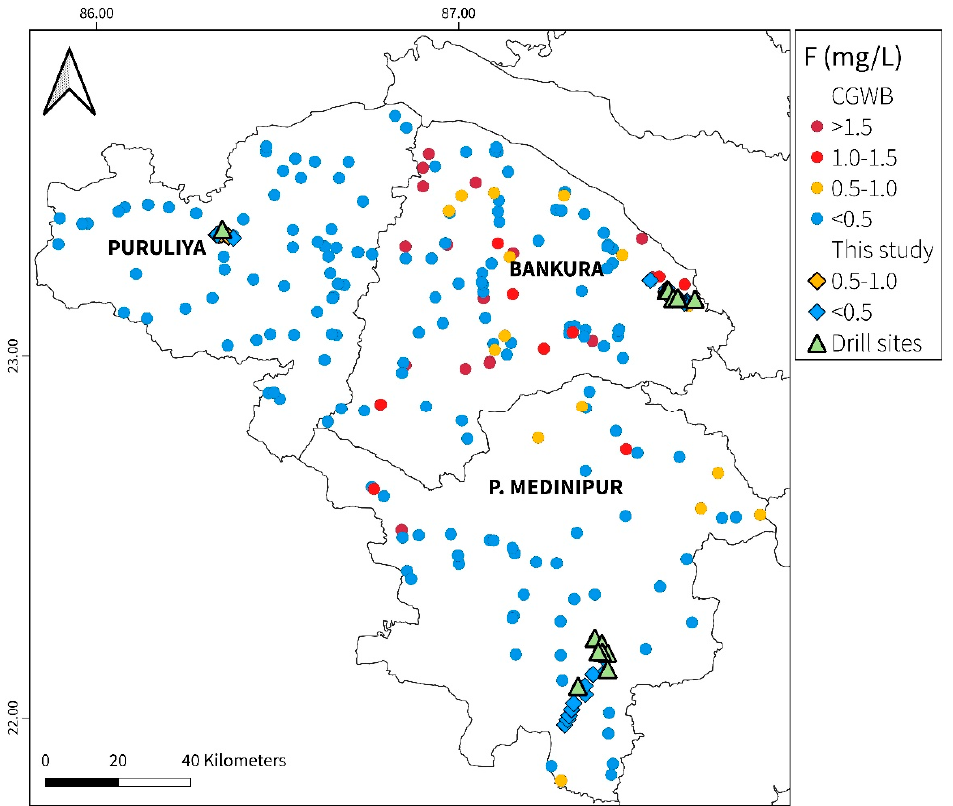
Figure 2. Groundwater F concentrations in the study area; circles represent data from CGWB, while diamond shapes represent samples from this study. Table 1. Statistical summary of the groundwater chemistry from 29 collected samples.